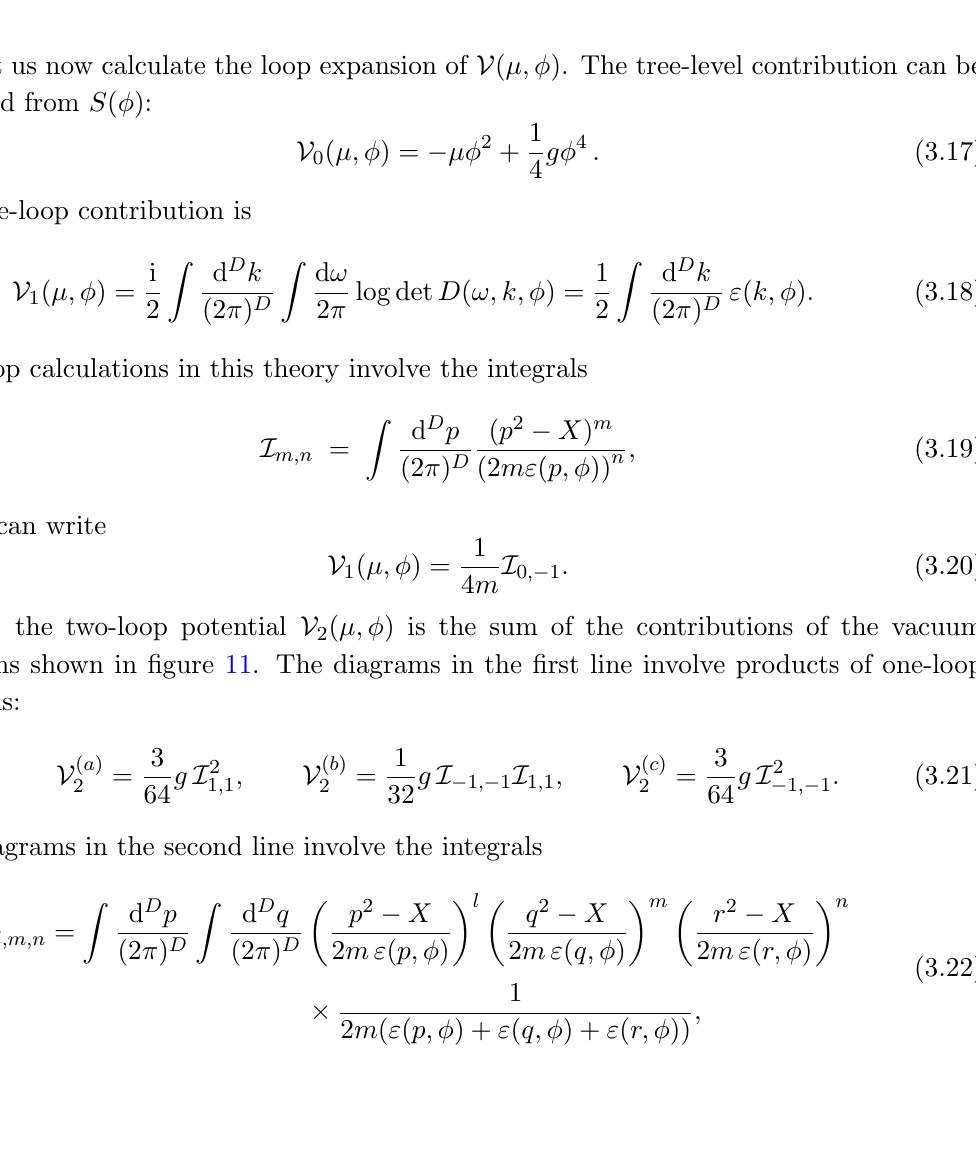
Figure 10 . The vertices for the interactions between (cid:17) , (cid:24)